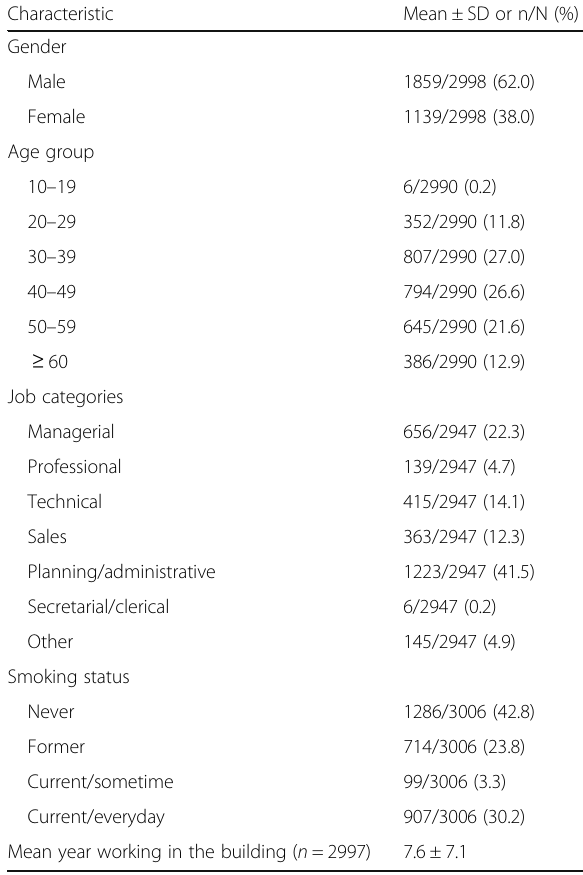
Table 1 Participant characteristics ( N =